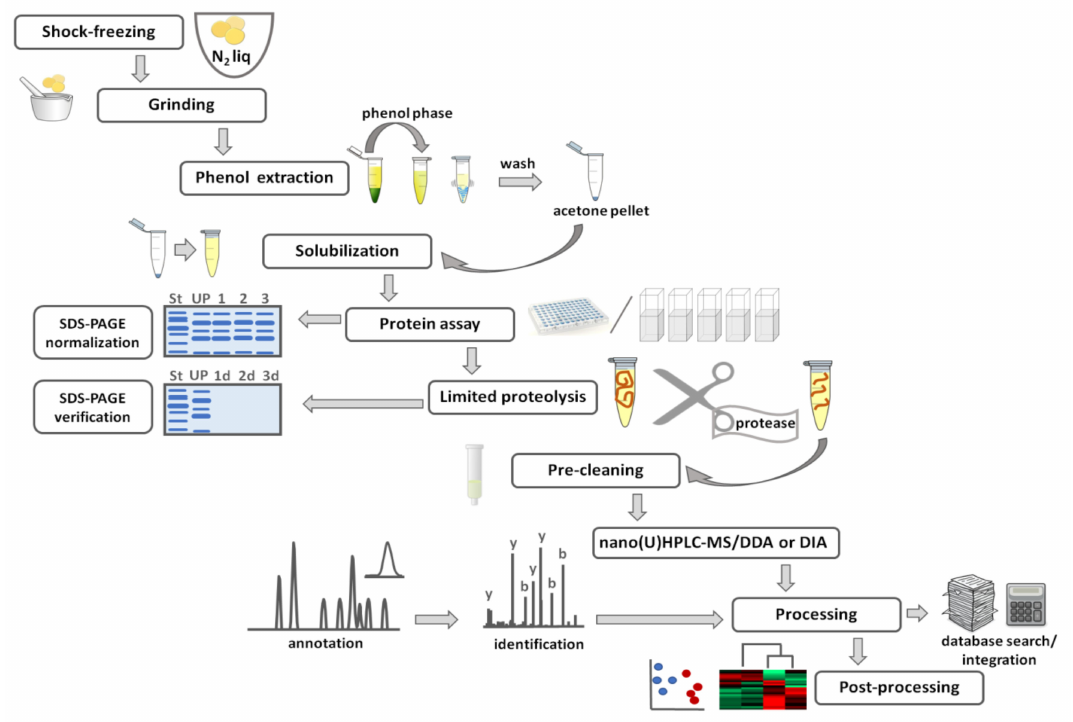
Figure 3. Detailed workflow for LC-based proteomics: protein isolation, sample preparation, and